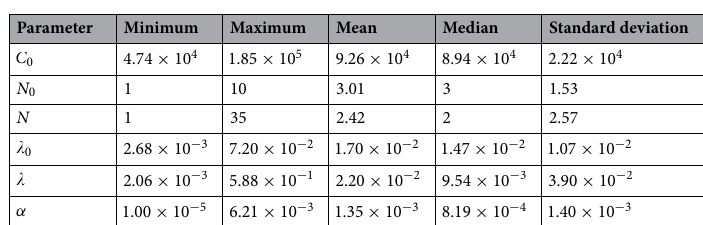
Figure 9. Posterior distributions (green and blue) for the parameters in the multi-stage ( A ) and exponential ( B ) model for F5 T cells. In the exponential model, the number of stages for all generations is equal to 1, i.e., 1 . Prior distributions are shown in red. N 0 N = =